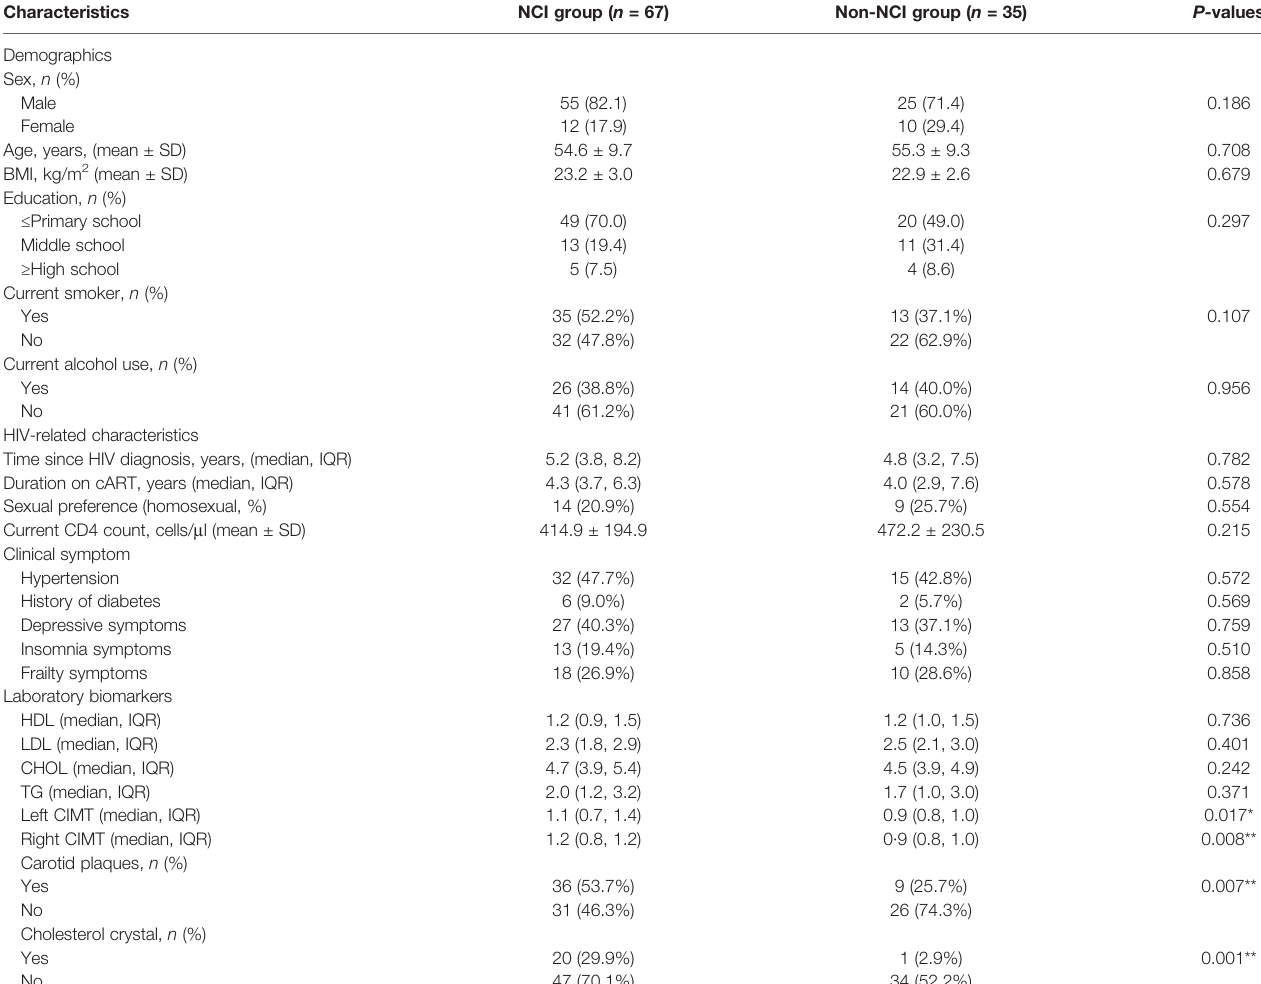
TABLE 1 | Characteristics of the NCI and non-NCI groups ( n = 102).